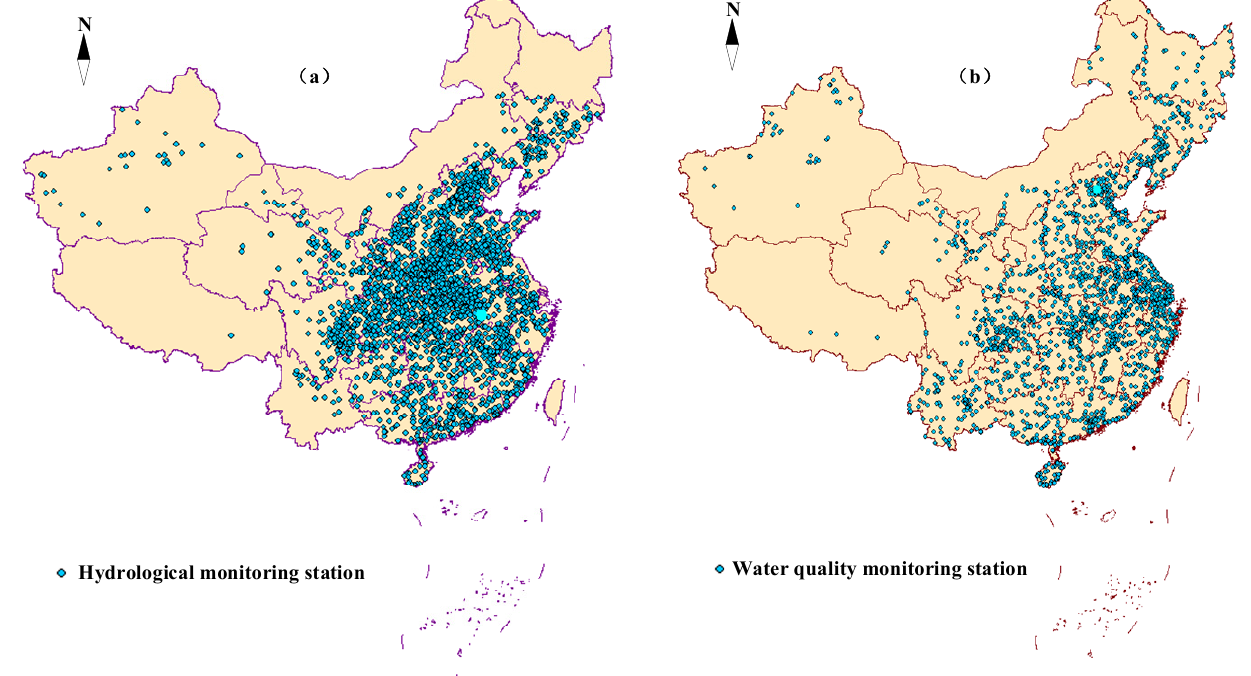
Figure 6. Distribution of hydrological monitoring stations ( a ) and water-quality-monitoring stations ( b ).